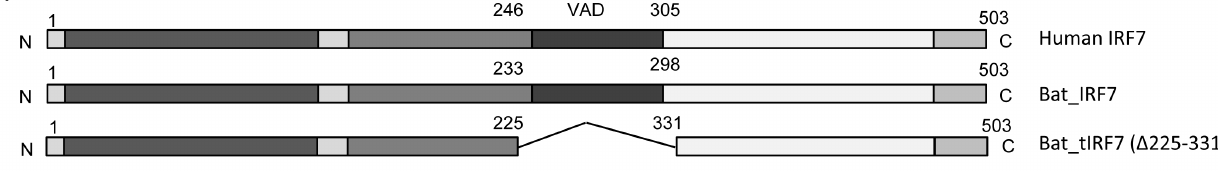
Figure 6. Bat IRF7 interacts with bat MyD88. (A) Binding of bat IRF7 to bat MyD88. HEK293T cells were transfected with GFP-tagged IRF7 and FLAG-tagged MyD88 (human or bat, as indicated). At 24 h post-transfection, whole cell lysate was prepared and immunoprecipitated with anti- FLAG antibody M2. Immunoprecipitated complexes (IP) were analysed by immunoblot for IRF7 and MyD88 expression using an anti-human IRF7 antibody (top panel), and an anti-FLAG antibody M2 for detection of FLAG tagged MyD88 (middle panel). Whole cell lysate (10 ul) was also run on an SDS-PAGE gel and subsequently analysed for IRF7 expression using anti-human IRF7 antibody (bottom panel). (B) Bat IRF7 co-localizes with bat MyD88. PaKiT03 cells were transfected with bat GFP-IRF7/IRF3 and bat FLAG-MyD88 and HEK293T cells were transfected with human GFP-IRF7 and human or bat FLAG-MyD88. 16 hours post-transfection (or 24 h), cells were fixed for indirect immunofluorescence assay using an anti-human MyD88 antibody and red fluorescence-conjugated secondary antibody. Pictures show co-localisation of bat IRF7 or bat IRF3 with bat MyD88 in PaKiT03 cells and human IRF7 or human IRF3 with human MyD88 in HEK293T cells.